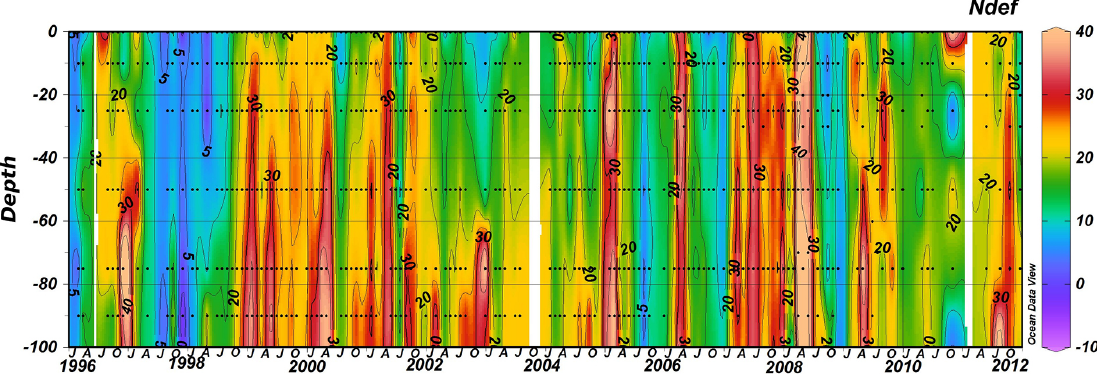
Figure 5. Time series of N deficit (µmolL − 1 ) at St. 4 off Callao during 1996–2011. Black dots represent the data, and the figure presents a DIVA 2017 graphic interpolation only for the visualization of the